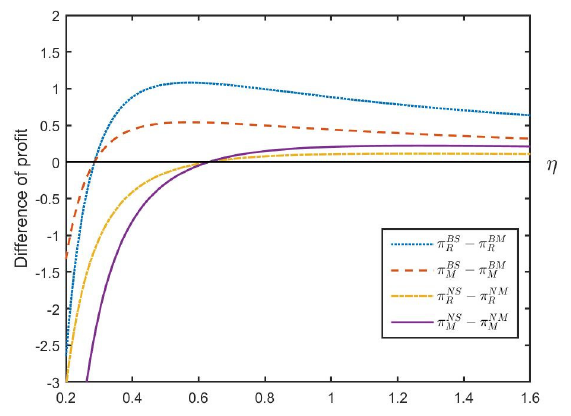
Figure 10. Impact of η on profit difference. ( α = 2.2, φ = 0.68 ).